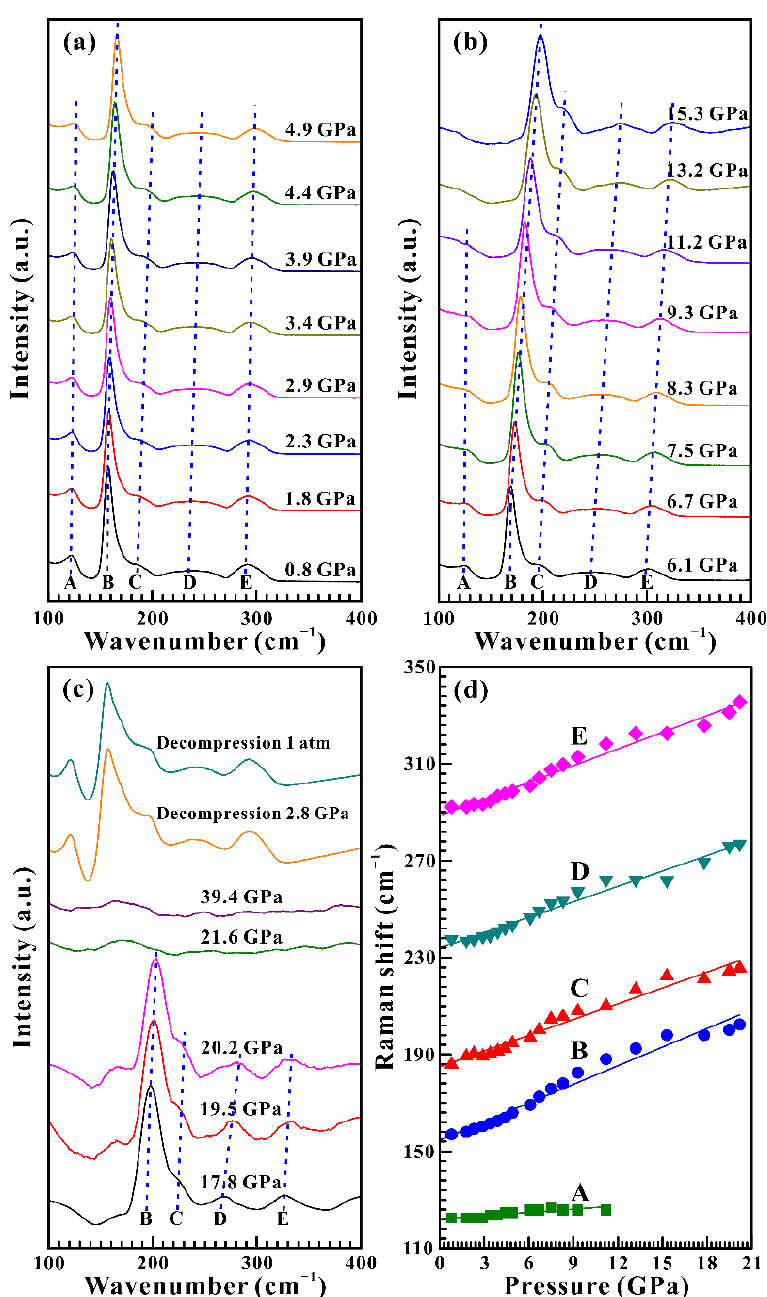
Figure 4. ( a – c ) Raman spectra of Ga 2 Se 3 at the pressure range of 0.8–39.4 GPa during compression, and the Raman spectra at the pressure points of 2.8 GPa and 1atm during decompression; ( d ) Pressure-dependent Raman shifts for Ga 2 Se 3 under hydrostatic conditions. In here, the A, B, C, D and E modes stand for the Raman peaks at 122.5, 157.0, 185.9, 237.6, and 292.2 cm − 1 acquired at 0.8 GPa, respectively. Table 1. Pressure-dependent Raman shift (dω/dP; cm −1 GPa −1 ) for Ga 2 Se 3 under non-hydrostatic and hydrostatic environments. Here, ω and P are the Raman frequency and pressure, respectively. The listed ω values are obtained at 0.4 GPa under non-hydrostatic conditions and at 0.8 GPa under hydrostatic conditions, respectively.